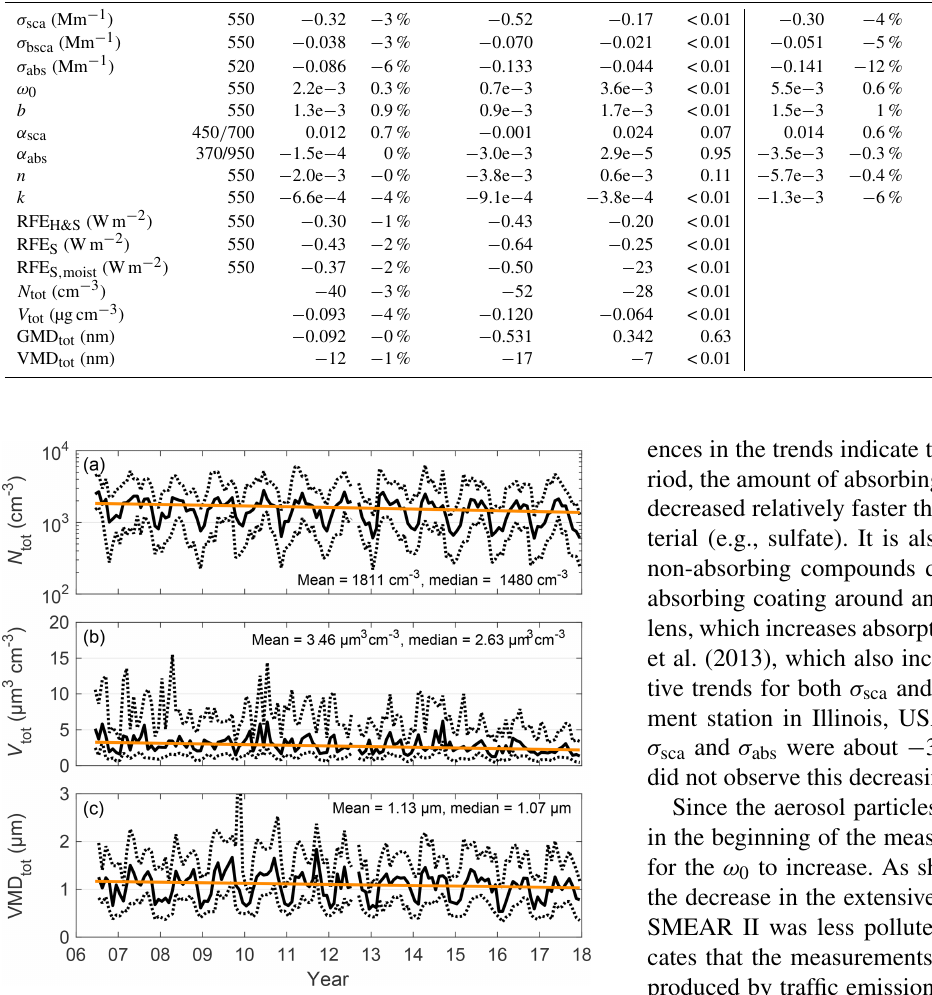
Figure 5. Time series and trends of the total particle ( D p <10µm) (a) number concentration ( N tot ) , (b) volume ( V tot ), and (c) VMD tot . The mean and median values of the variables are also marked in the subfigures and the statistics of their slopes are presented in Table 3. The explanations for the different lines are the same as in Fig.